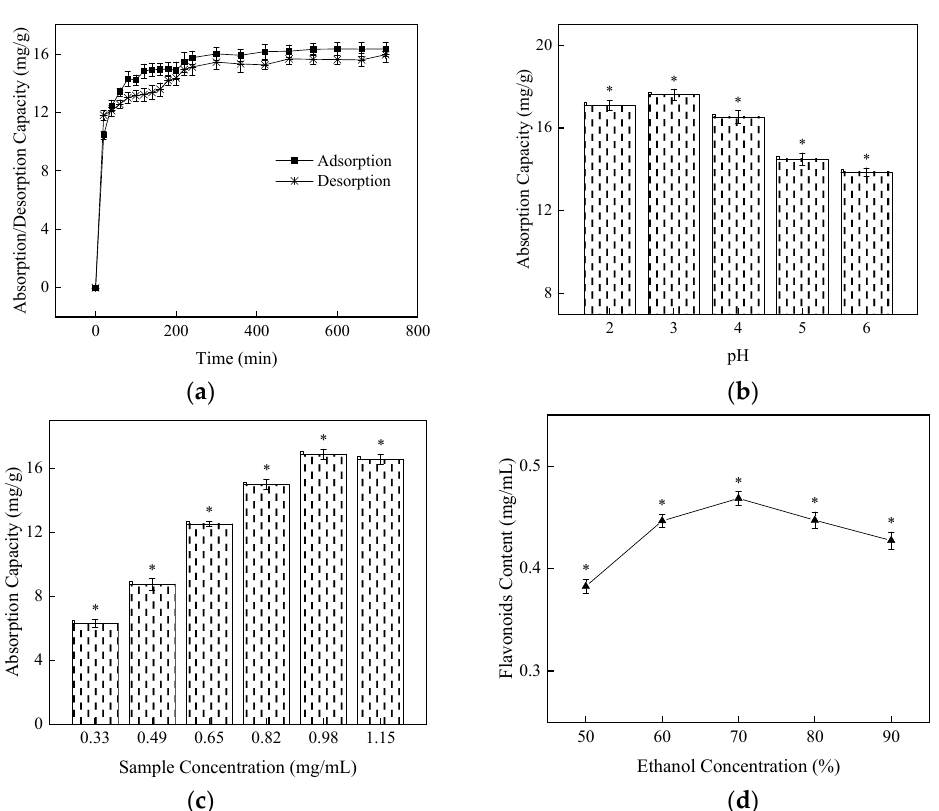
Figure 3. Effects of different factors on static adsorption and desorption of AB-8. ( a ) Adsorption and desorption curve; ( b ) Influence of pH on adsorption; ( c ) Influence of sample concentration on adsorption; ( d ) Influence of ethanol concentration on desorption. The data shows as the mean ± S.D. ( n = 3). *: p < 0.05 compared between groups.